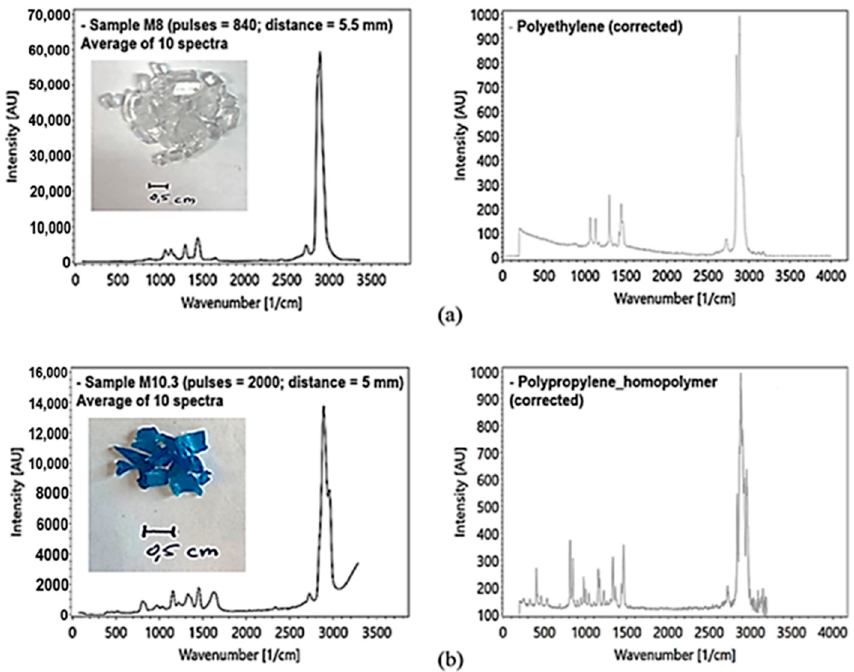
Figure 18. ( a ) PE sample, transparent, Raman measured with the rotary table, averaging of 10 spectra (( a ) left) with reference spectra of PE (( a ) right) by [39]; ( b ) PP sample, blue, Raman measured with the rotary table, averaging of 10 spectra (( b ) left) with reference spectrum (( b ) right) by [39].